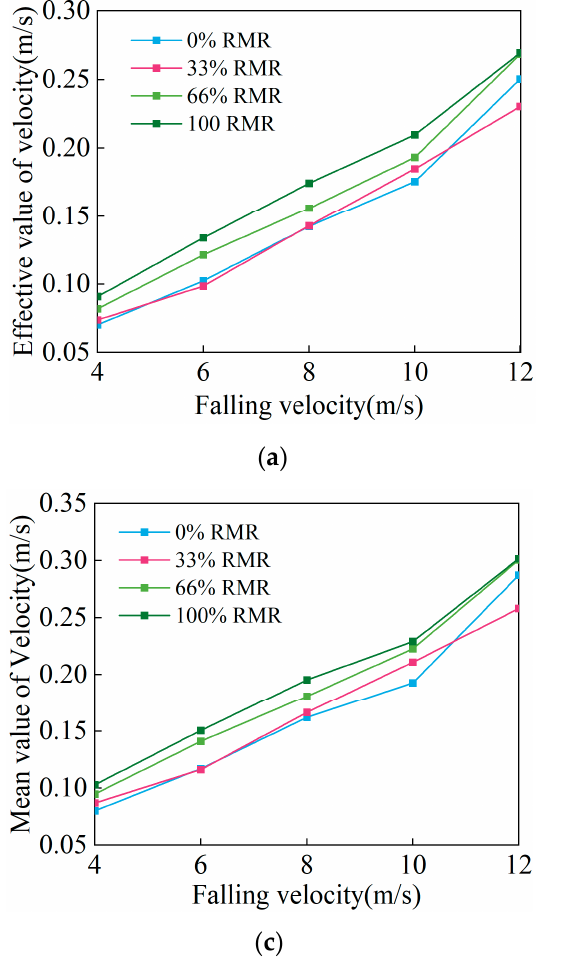
Figure 10. ( a ) Falling velocity versus effective value of velocity under different RMR. ( b ) Falling velocity versus effective value of acceleration under different RMR. ( c ) Falling velocity versus mean value of velocity under different RMR. ( d ) Falling velocity versus mean value of acceleration under different RMR.